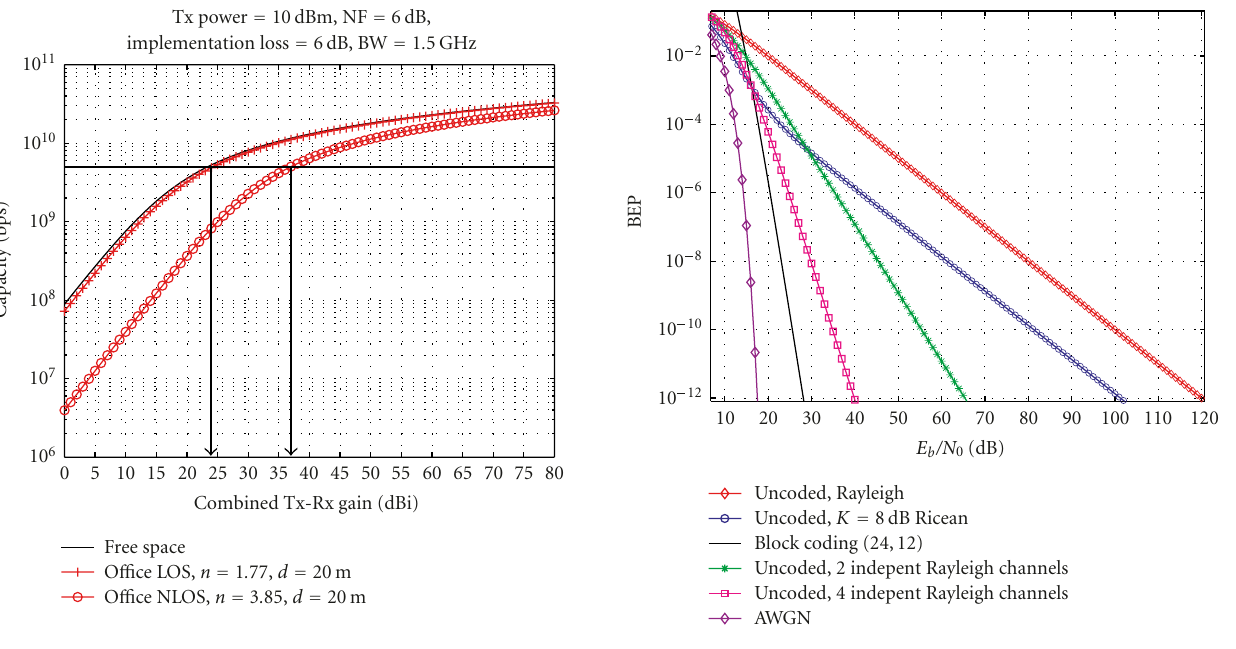
Figure 4: The BEP for the case of uncoded, coded, and diversity systems in Rayleigh fading